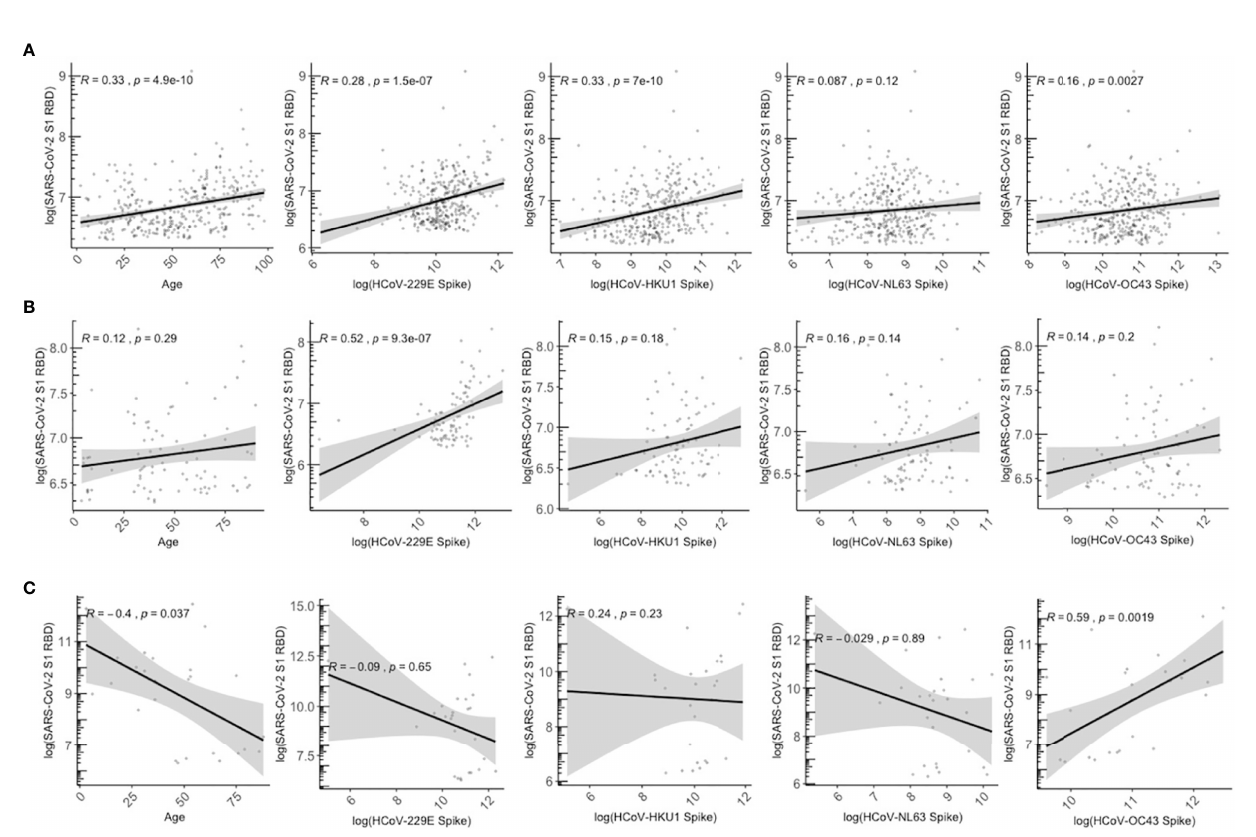
FIGURE 6 | Relationship between age and HCoV-speci fi c IgG antibodies with SARS-CoV-2 S1 RBD antibodies among SARS-CoV-2 overall sero-negative persons who are positive for SARS-CoV-2 S1 RBD antibodies. (A) describes all individuals from 2013 season who have SARS-CoV-2 S1 RBD antibodies above positivity cutoff (N = 329). (B) describes SARS-CoV-2 sero-negative individuals from 2020 who have SARS-CoV-2 S1 RBD above positivity cutoff (N = 87). (C) describes SARS-CoV-2 sero-positive individuals from 2020 who also have SARS-CoV-2 S1 RBD above positivity cutoff (N = 27). SARS-CoV-2 sero-positive individuals are from the serosurvey cohort (N = 8) and the known positive controls added (N = 27). Gray shaded area indicates 95% con fi dence intervals. Spearman correlations were used to describe the relationship between samples, and corresponding Spearman correlation coef fi cient (R) and p-values are